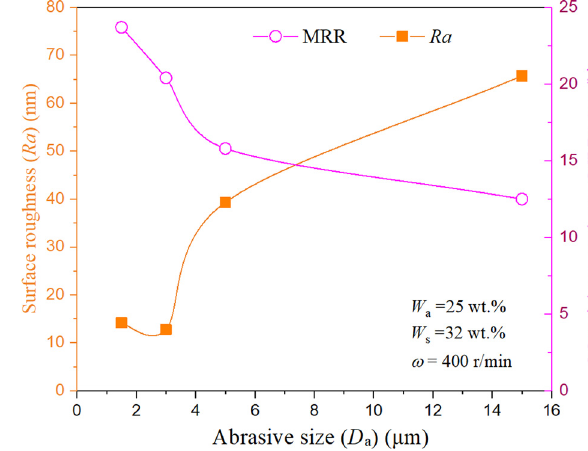
Figure 4: In fl uence of di ff erent abrasive size of Al 2 O 3 on surface roughness Ra and